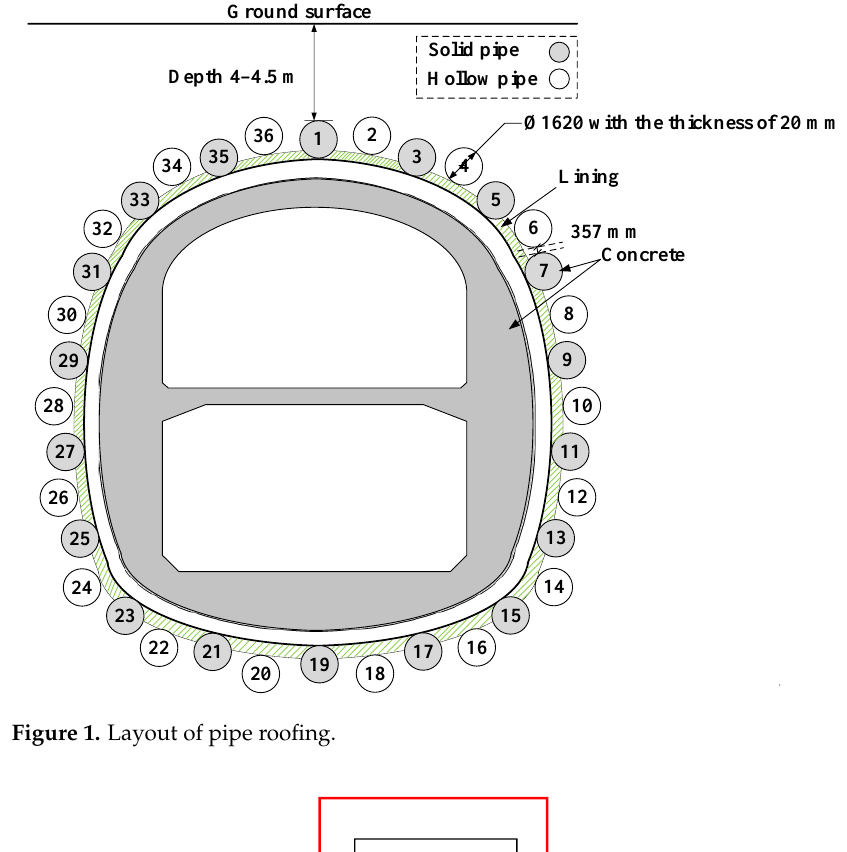
Figure 1. Layout of pipe roofing. Considering the calculation efficiency and symmetry of the structure, the typical part of the above-mentioned FSPR was taken as the research object, including solid steel pipe, hollow pipe, and the frozen soil between pipes, as shown in Figure 2.